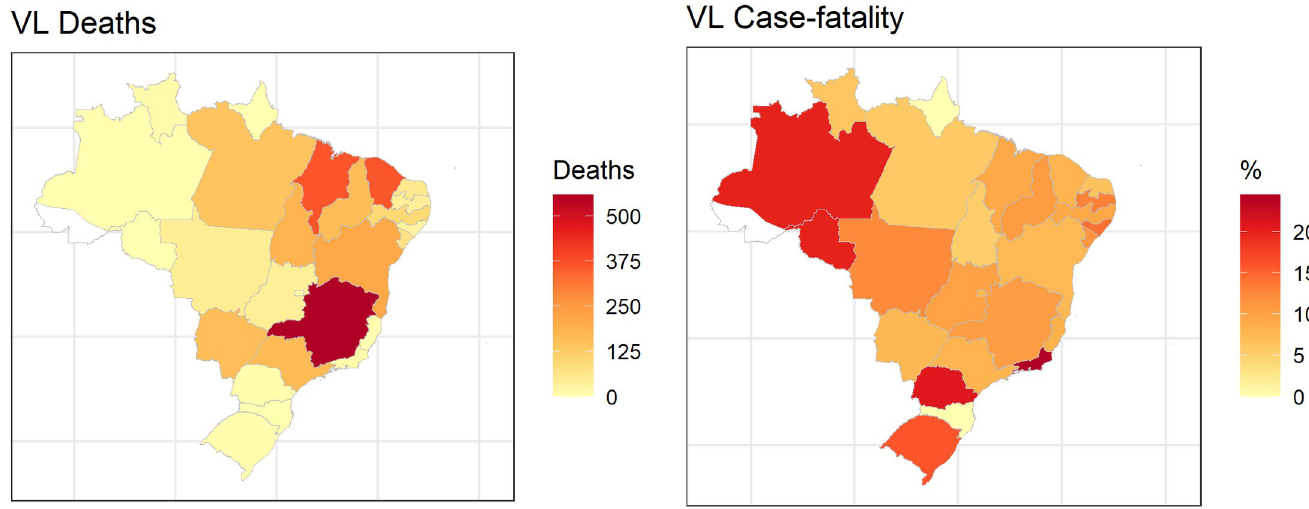
Fig 2. Spatial distribution VL deaths (left) and case-fatality in the FUs (right), Brazil, 2007–2017. The maps were built using the free and open source R software (https://www.R-project.org/.) based on shapefiles obtained from Instituto Brasileiro de Geografia e Estatı´stica-IBGE) (https://portaldemapas.ibge.gov.br/portal.